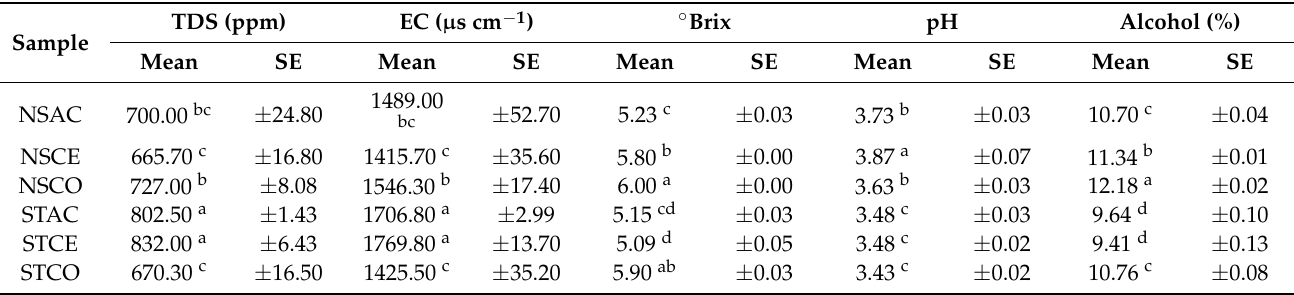
Table 2. Results from the chemical measurements.